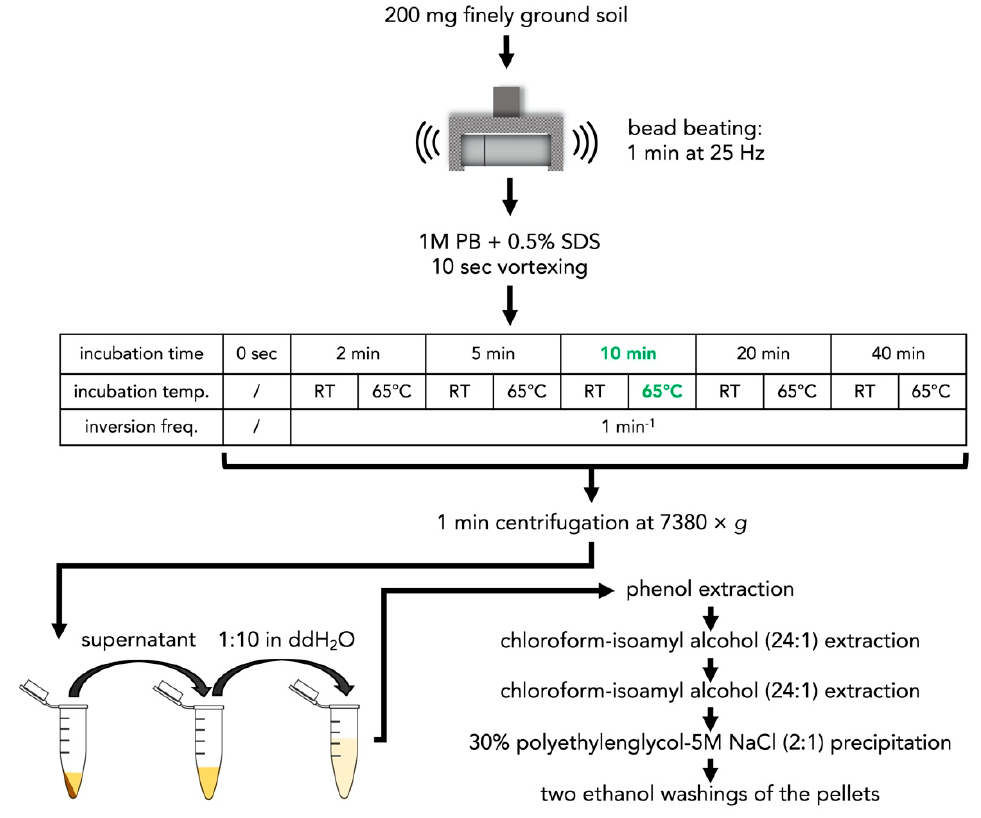
Figure 2. Workflow illustration of the incubation temperature and time gradient of the soil/PB with 0.5% SDS suspension. ddH 2 O = double ‐ distilled water; PB = phosphate buffer; RT = room temperature; SDS = sodium dodecyl sulfate.